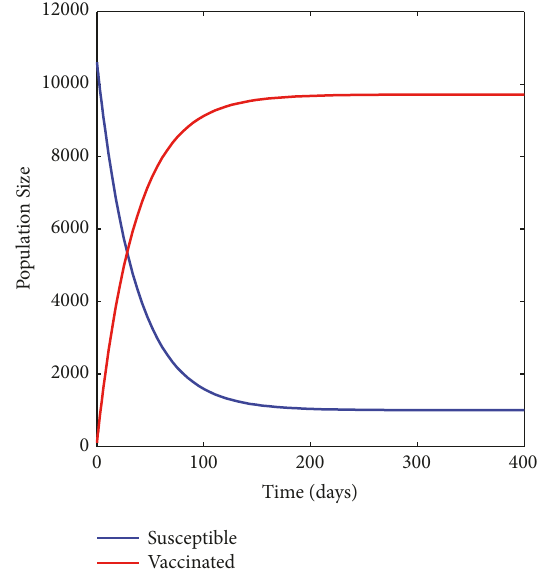
Figure2:Simulationofmodel(1),thedisease-freeequilibrium,with populations parameters: 𝜙 = 3.57144 × 10 −1 , 𝛽 = 1.0102 × 10 −5 , ] = 2.53 × 10 −2 , and 𝛾 = 3.3333 × 10 −2 (with 𝑅 and 𝑅 V 0 = 0.6490